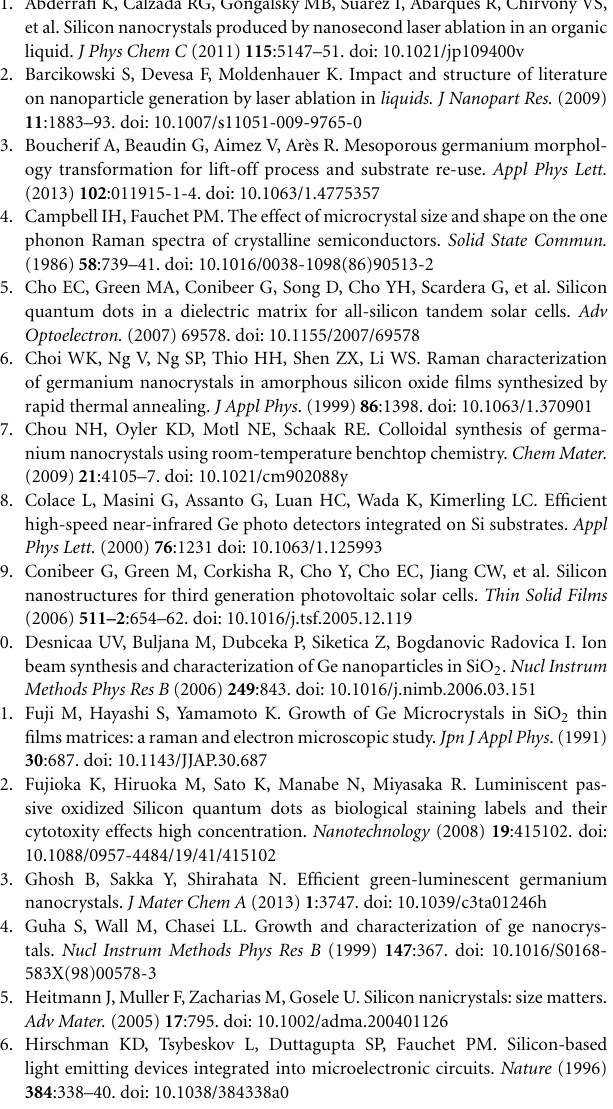
FIGURE 8 | Photoluminescence spectra of Ge NPs colloids prepared at different laser input